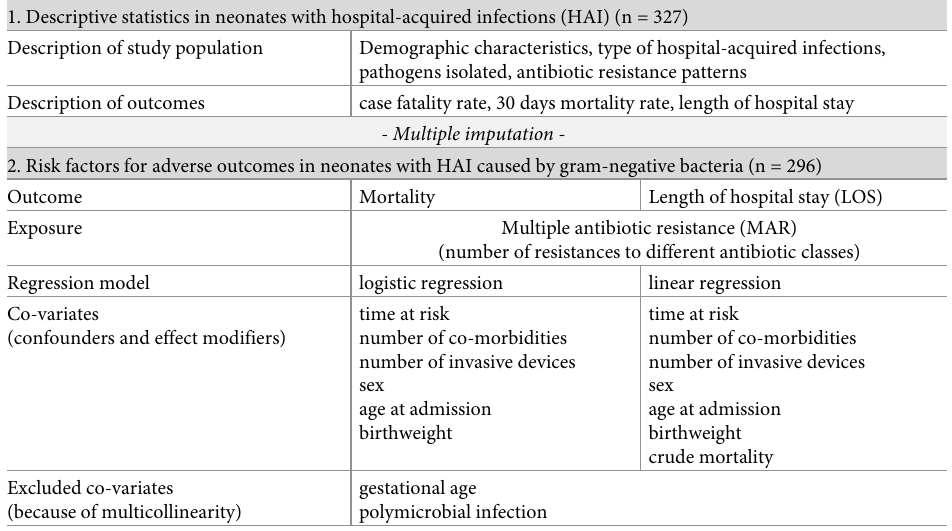
Table 1. Overview of methodological approach.